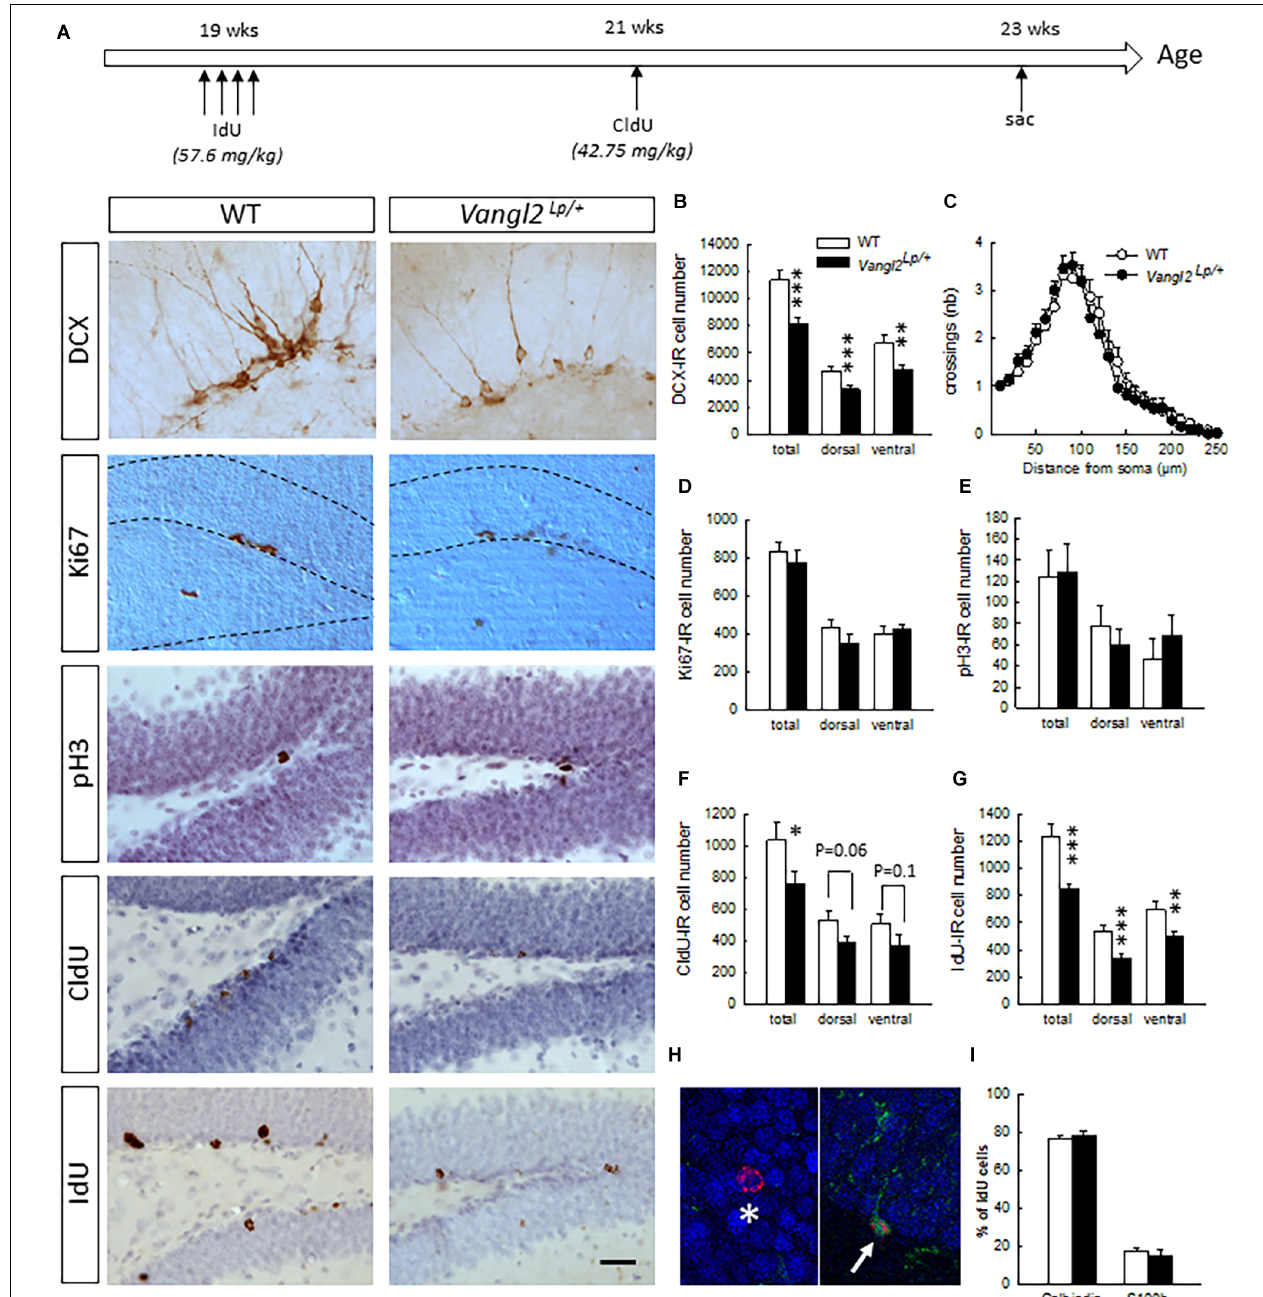
FIGURE 1 | Vangl2 lp mutation decreases survival of adult-born cells in the hippocampal neurogenic niche. (A) Timeline of the experiment and representative images of immunostainings in WT and Vangl2 Lp/+ mice. (B) Number of immature neurons (DCX-IR). (C) Sholl morphometric analysis of DCX-IR cells. (D) Number of Ki67-IR proliferating cells. (E) Number of pH3-IR proliferative cells. (F) Number of 2-week-old surviving cells (CldU-IR). (G) Number of 4-week-old surviving cells (IdU-IR). (H) Illustration of a 4-week-old newborn neuron (IdU-Calbindin-IR cell, white star) and a 4-week-old newborn glial cell (IdU-S100-IR cell, white arrow). (I) Percentages of neuronal and glial differentiation of 4-week-old IdU-IR cells. White bars, WT n = 6–7 mice ; Black bars, Vangl2 Lp/+ n = 8–9 mice; white dots: dendrites WT n = 42 neurons (23 in the dorsal and 19 in the ventral DG); black dots, dendrites Vangl2 Lp/+ n = 32 neurons (18 in the dorsal and 14 in the ventral DG). ∗ p < 0.05; ∗∗ p < 0.01; ∗∗∗ p < 0.001. Scale bar = 50 µ m.